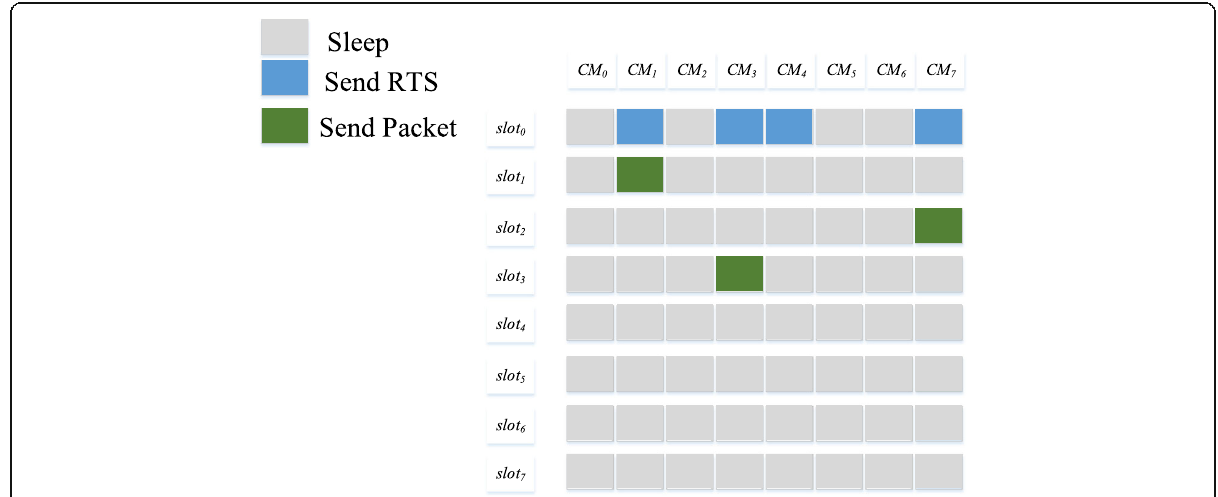
Fig. 4 Schematic diagram of the workflow of the CM